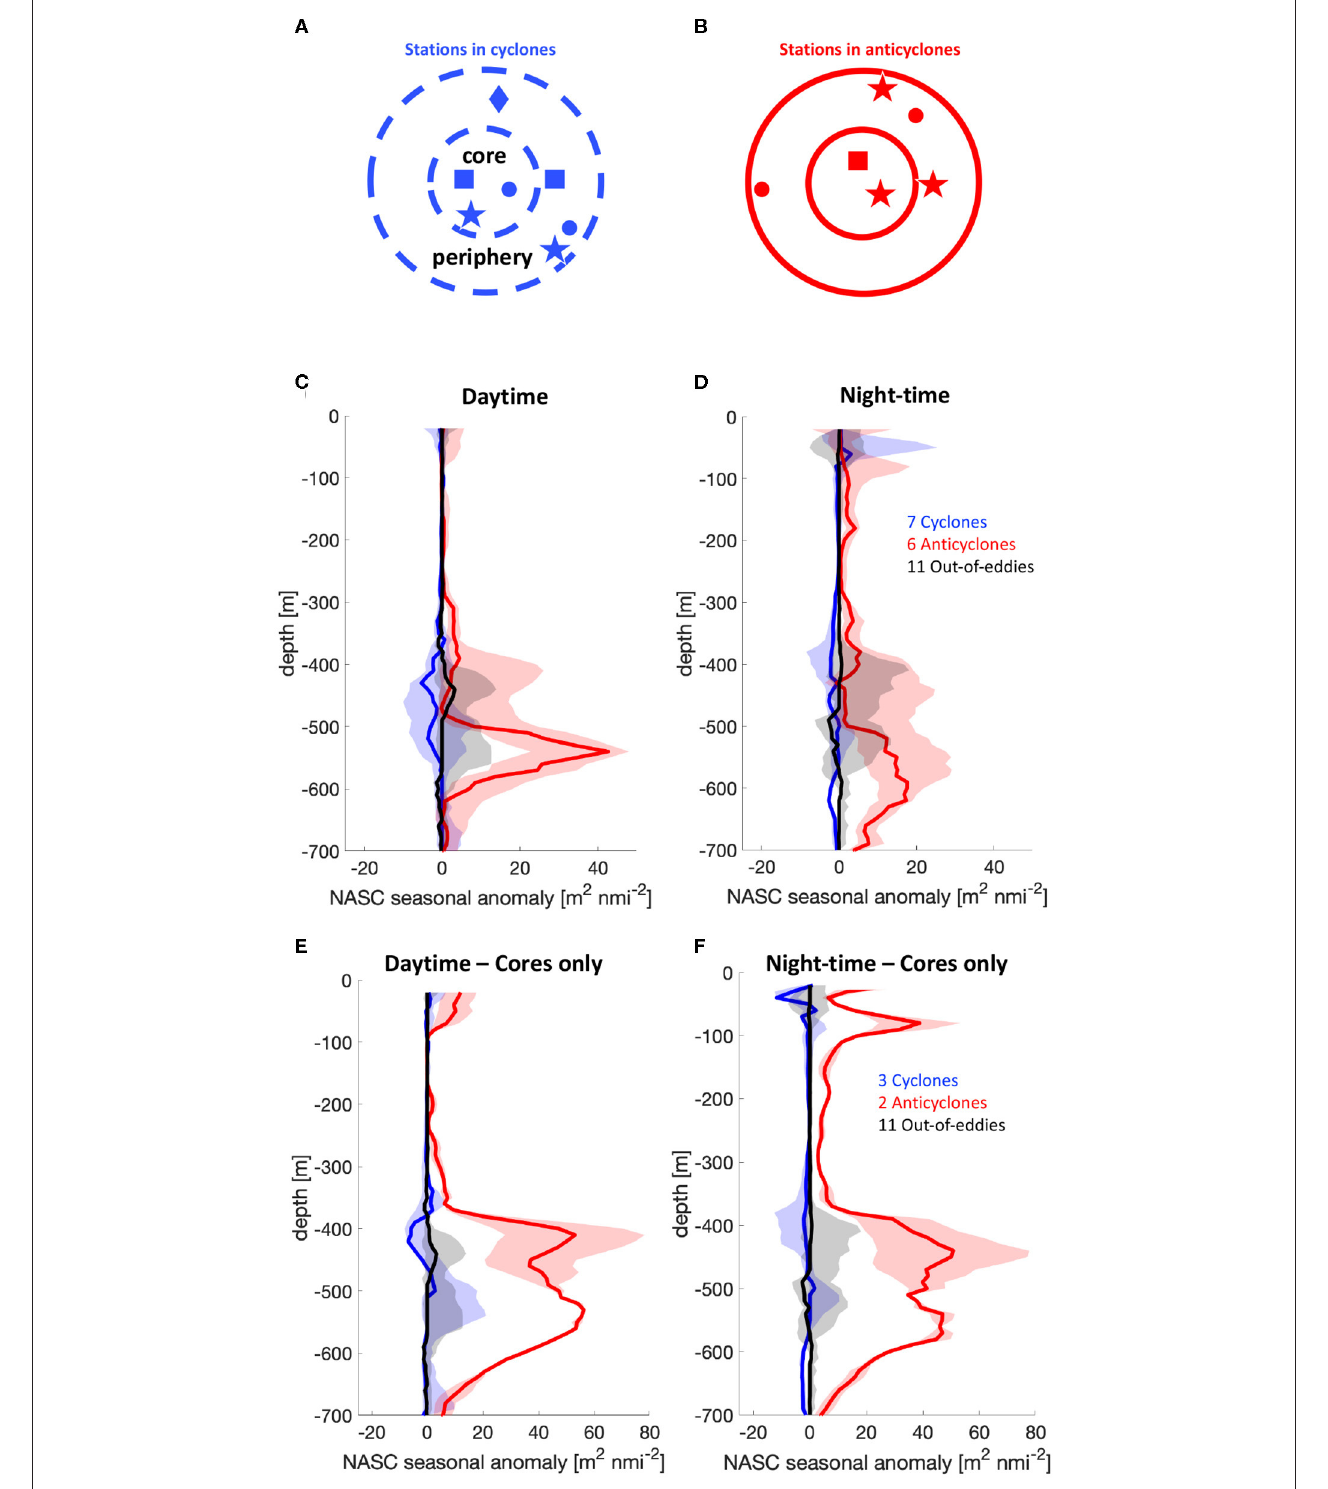
FIGURE 2 | Schematic of the sampled eddies and the location of the sampling in respect to the estimated location of the cores of cyclones (A) and anticyclones (B) . Daytime (C) and night-time (D) NASC seasonal median anomalies (lines) for cyclones (blue, referring to the stations inside the outer dashed circle in A ), anticyclones (red, referring to the stations inside the outer solid circle in B ) and out-of-eddy (black) stations. Colored bands indicate the respective 15th and 85th percentiles divided by the square root of the number of observations. (E,F) The same diagnostics we calculated using only the locations inside eddy cores (i.e., inside the inner circles in A,B